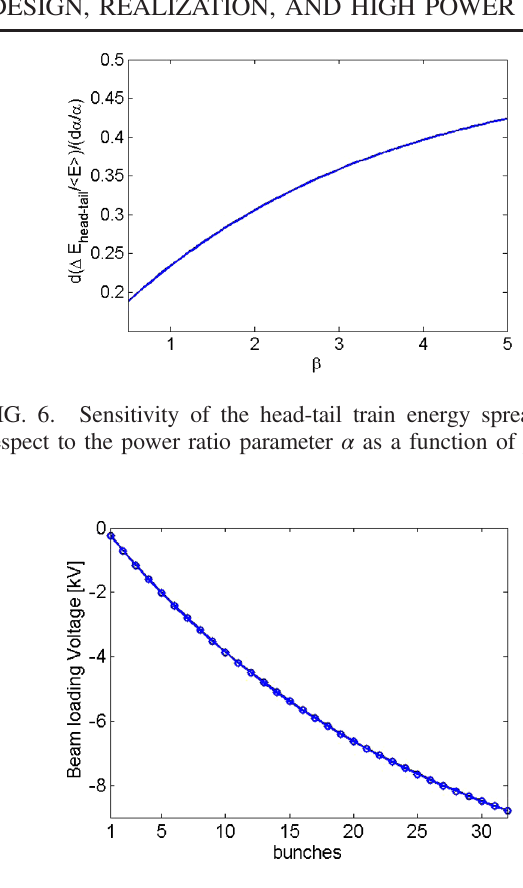
temperature.FIG. 7. Beam-induced voltage in the gun ( q ¼ 250 pC, 32 bunches, and bunch spacing equal to 16